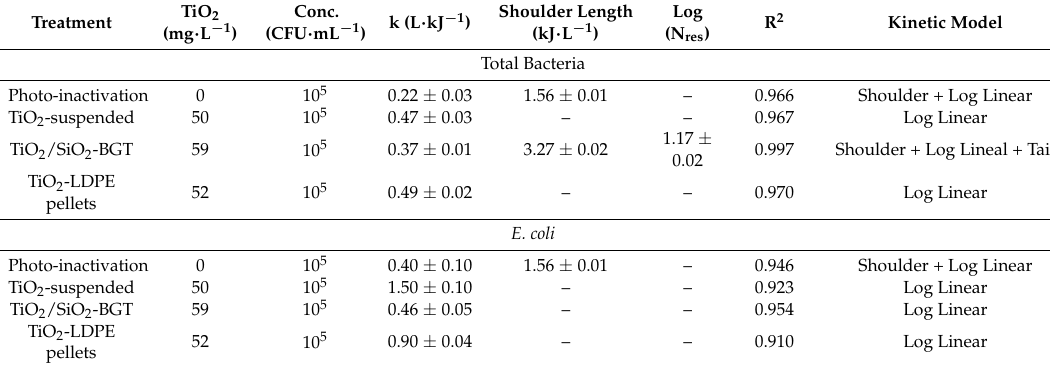
Table 3. Kinetic data of Total bacteria and E. coli photocatalytic experiments with suspended TiO 2 , TiO 2 /SiO 2 -BGT, and TiO 2 -LDPE